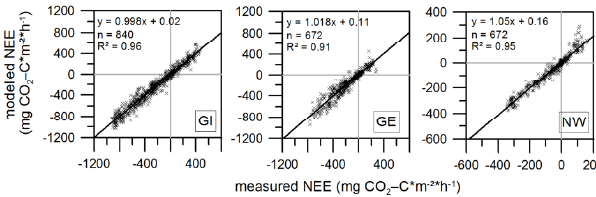
Fig. 6. Scatter plots for NEE model validation. Note the small underestimation at GI and slight overestimation of the GE and NW site.